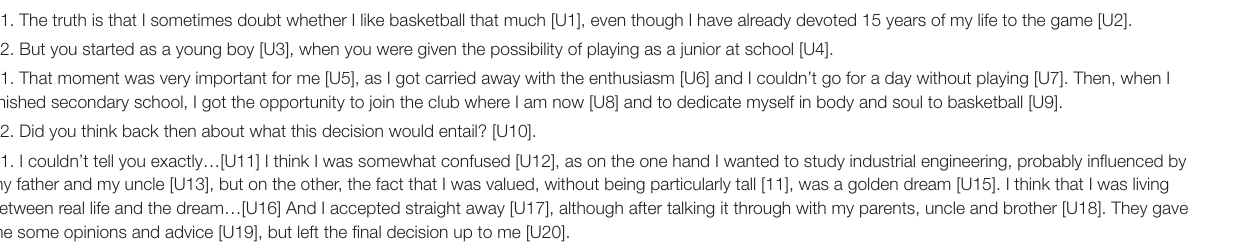
TABLE 1 | Vignette showing the segmentation of a text (transcribed from a conversation) into units. S1. The truth is that I sometimes doubt whether I like basketball that much [U1], even though I have already devoted 15 years of my life to the game